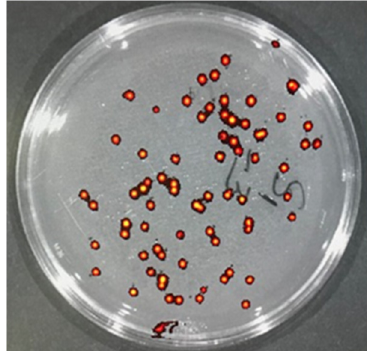
Figure 4. Representative image of LB agar-Amp plate on which a serial dilution of the bacteria from the skin tissue extract of a saline-treated wound was plated. All colonies exhibited robust GFP fluorescence, false colored yellow and red, when visualized using IVIS Spectrum CT Biophotonic Imager (excitation wavelength of 500 nm, emission wavelength of 540 nm, 2 s exposure time).